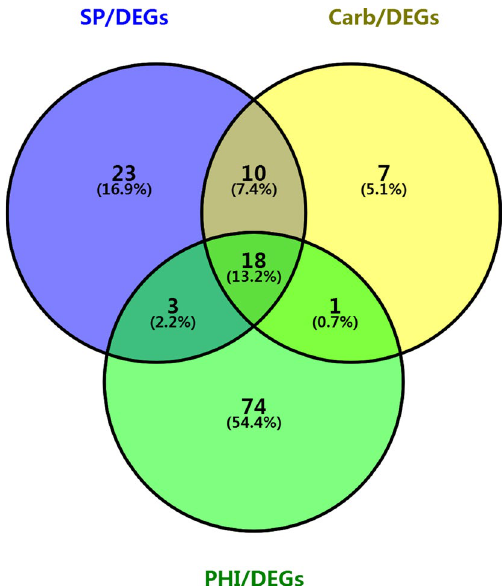
Figure 5. SP/DEGs, Carb/DEGs and PHI//DEGs Wayne figure. SP is abbreviation of secreted protein, DEGS is abbreviation of differentially expressed genes, Carb is abbreviation of CAZymes , PHI is abbreviation of pathogen–host interaction gene. TBtools was used for drawing program (https ://githu b.com/CJ-Chen/TBtoo ls/ relea